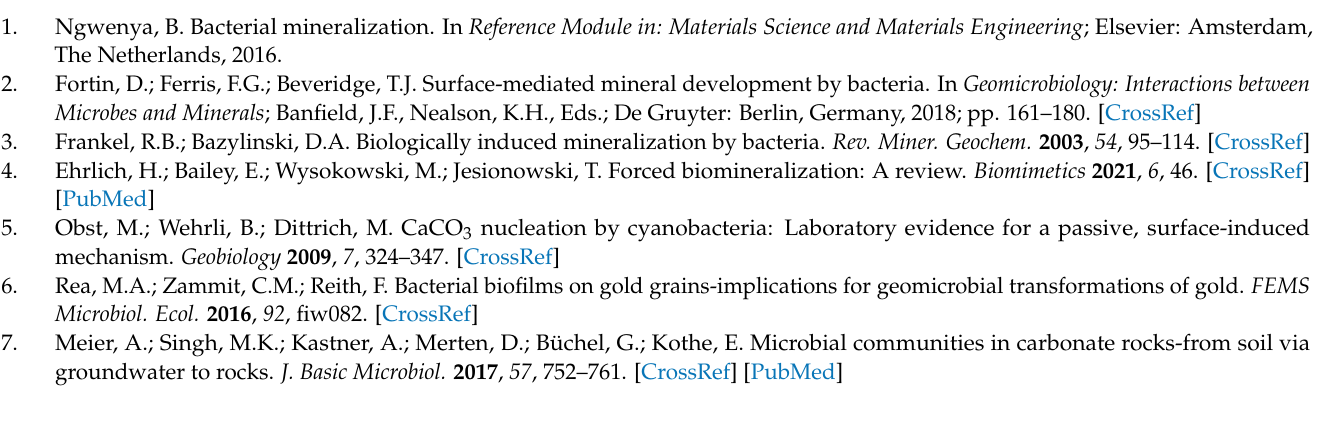
Figure S4: Crystals precipitated from liquid media and cell-free culture supernatant; Figure S5: Nickel concentration in the supernatant after growth of S. mirabilis P16B-1 with 5 or 10 mM NiSO 4 ; Figure S6: Concentrations of Ca, Fe, Mg, and K in the supernatant of S. mirabilis P16B-1 before and after precipitation of minerals; Figure S7: Protein sequence alignment of NreB proteins; Figure S8: Strategy for obtaining S. mirabilis ∆ p and S. lividans